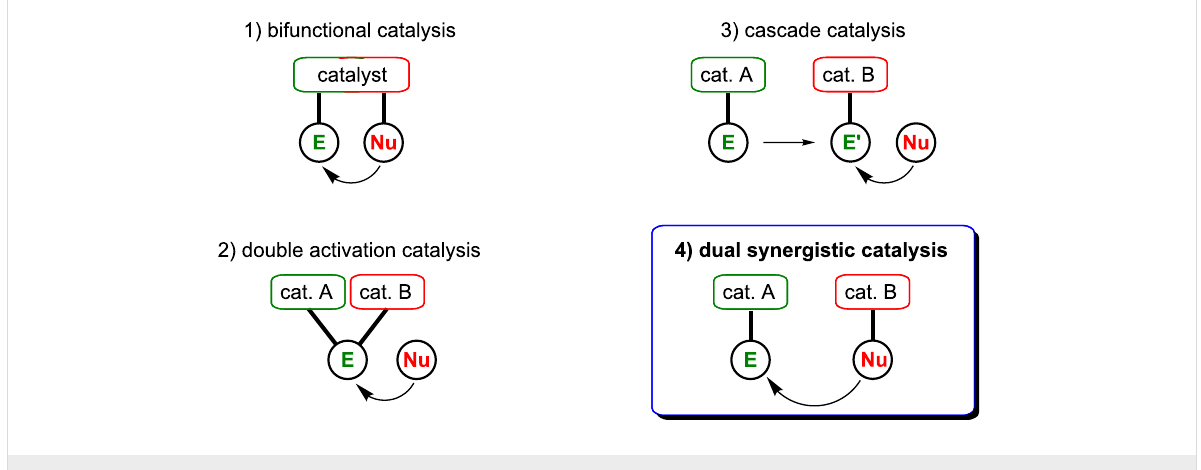
Figure 2: Classification of catalytic systems involving two catalysts.